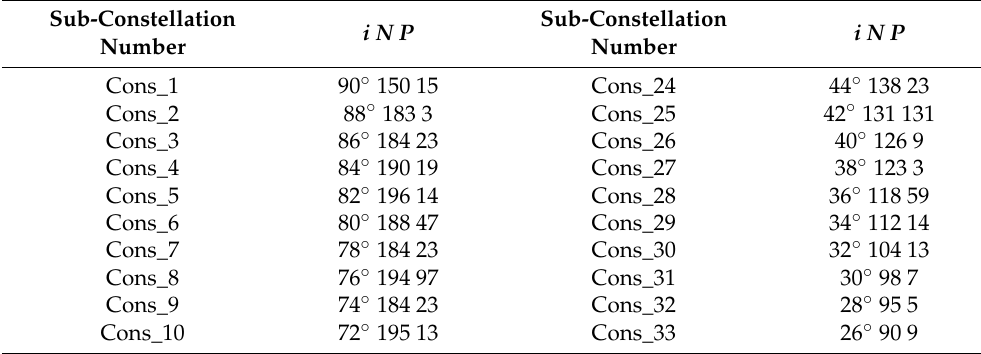
Table 1. Simulation results of the mega-constellation configuration.